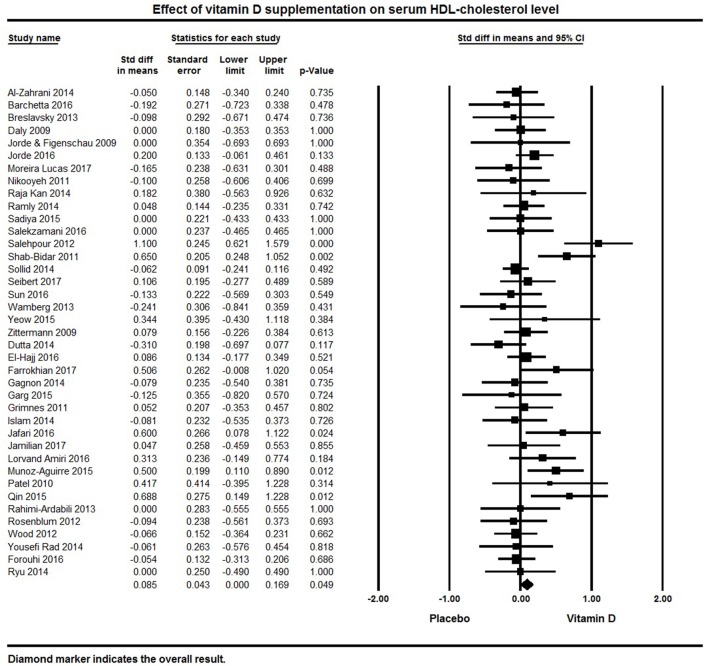
Forest plot detailing standardized mean difference for the impact of vitamin D on serum HDL-cholesterol level.